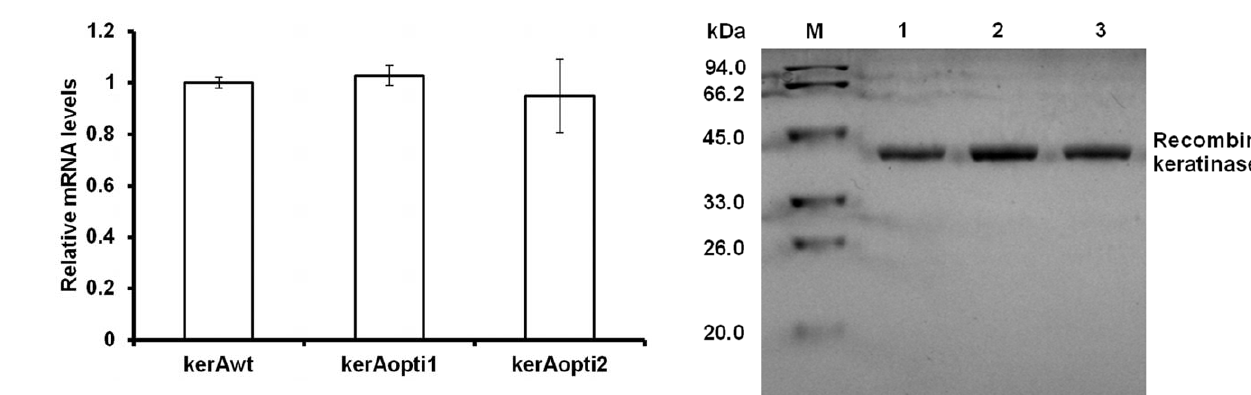
Figure 2. Comparative the target gene relative mRNA levels of P. pastori pPICZ a -kerAwt, pPICZ a -kerAopti1 and pPICZ a -ker- Aopti2. The values represent means 6 SD (n=3). Results showed no significant difference in target gene relative mRNA levels of every positive transformant (P . 0.05).